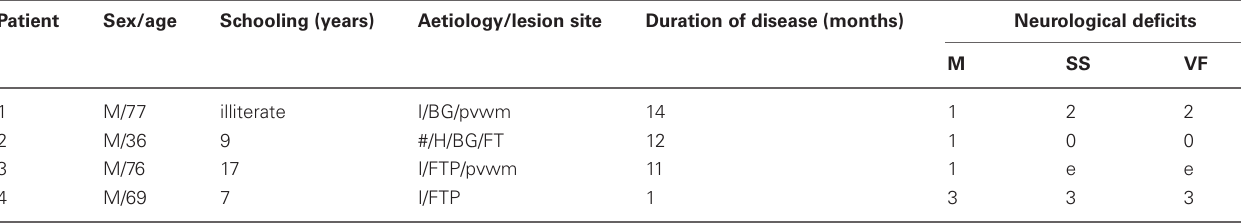
Table 1 | Demographic and neurological characteristics of four right-brain-damaged, right-handed patients.